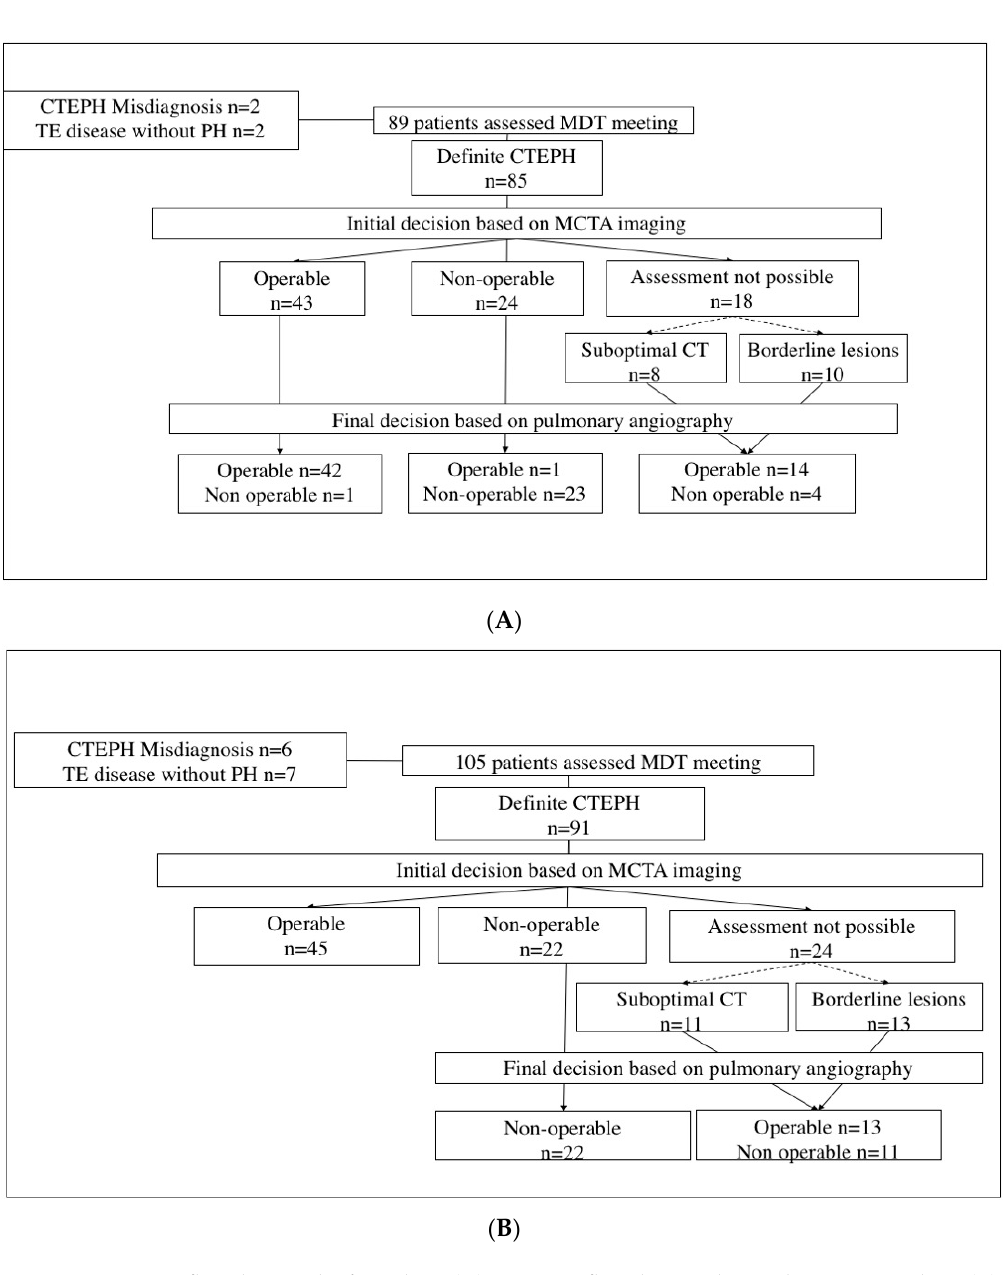
Figure 3. Decision flowchart in the first phase ( A ). Decision flowchart in the implementation phase ( B ). CTEPH = chronic thromboembolic pulmonary hypertension; TE = thromboembolic; PH = pulmonary hypertension; MDT = multidisciplinary team; MCTA = multidetector computed tomographic angiography; CT = computed tomography.